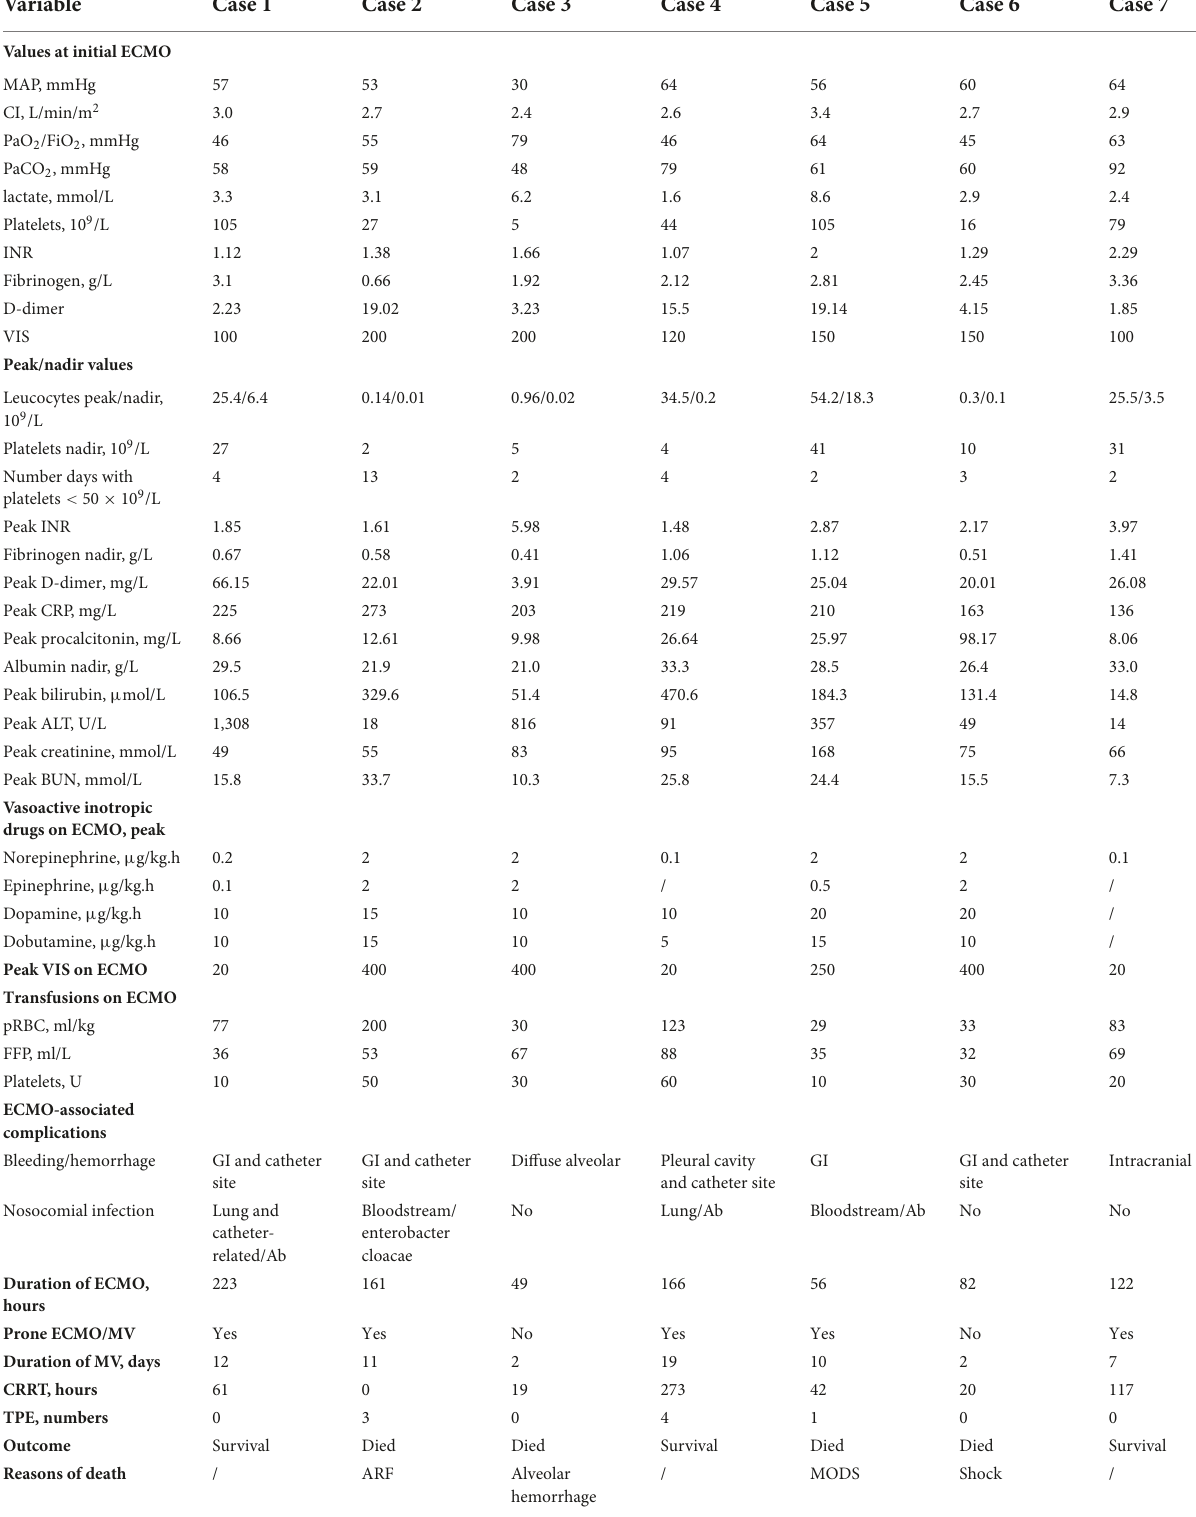
TABLE 2 Clinical and laboratory characteristics in pARDS on ECMO with leukemia/lymphoma. Variable Case